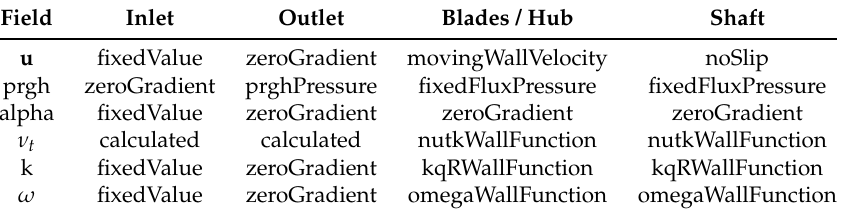
Table 2. An overview of the boundary conditions